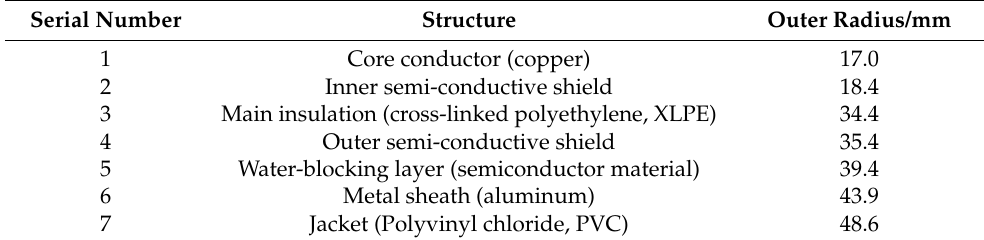
Table 1. Parameters of cross-sectional structure of the cable 1 .